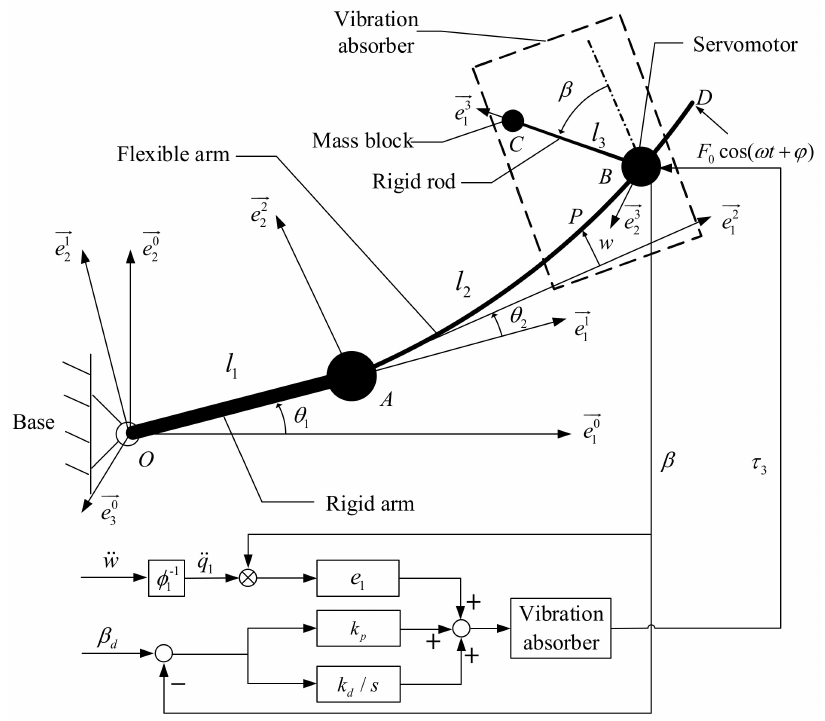
Figure 3. Control model of saturation vibration